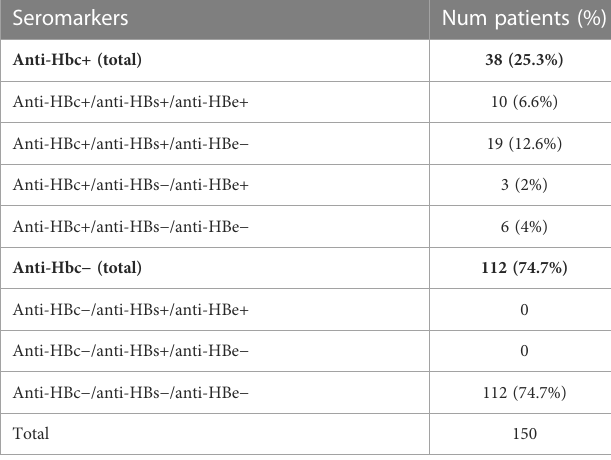
TABLE 2 Seromarker